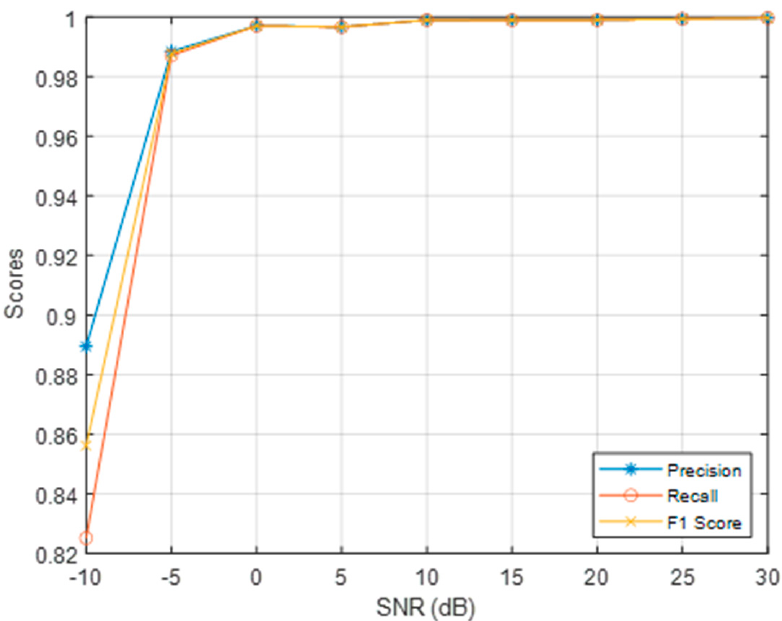
Figure 7. Performance of affinity propagation clustering.